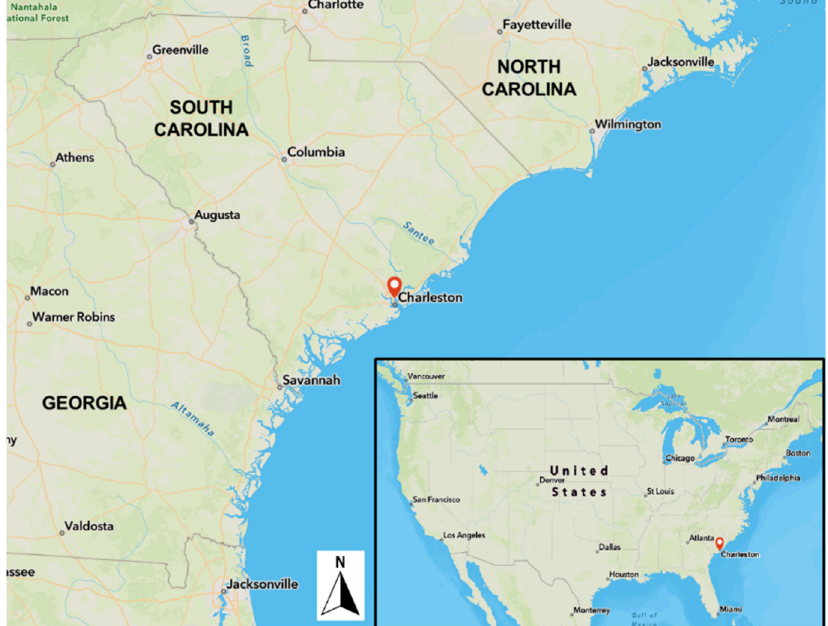
Figure 1. Map showing location of Charleston, SC, on the US South Atlantic coast (prepared by J. Taylor using ArcGIS).